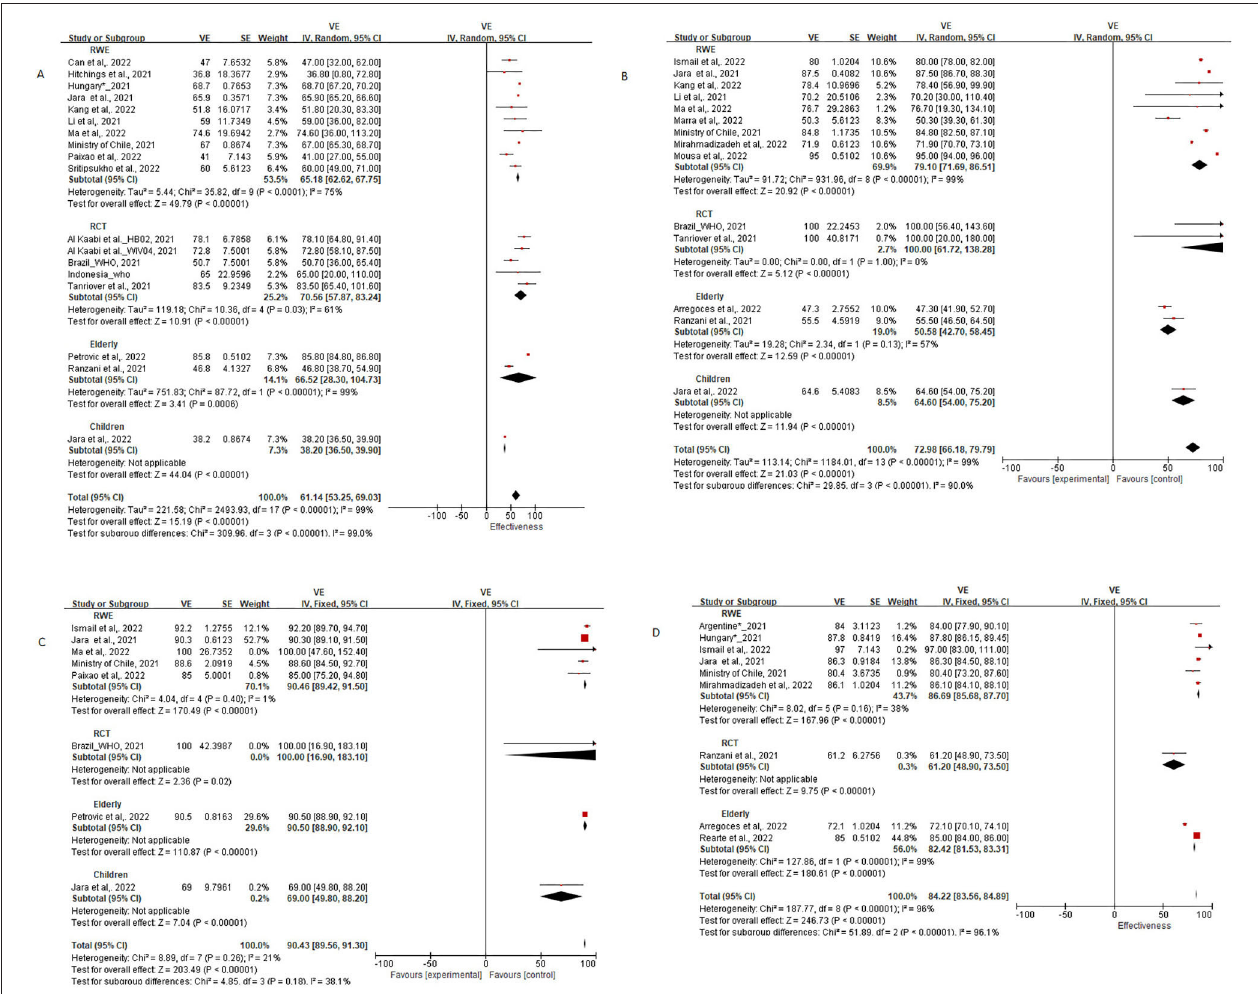
FIGURE 3 | Forest plots for the vaccine effectiveness (VE) of inactivated vaccine. (A) Forest plots against COVID-19 infection, (B) Forest plots against COVID-19 hospitalization, (C) Forest plots against COVID-19 ICU admission, (D) Forest plots against COVID-19 related death. * Internal data shared by company.